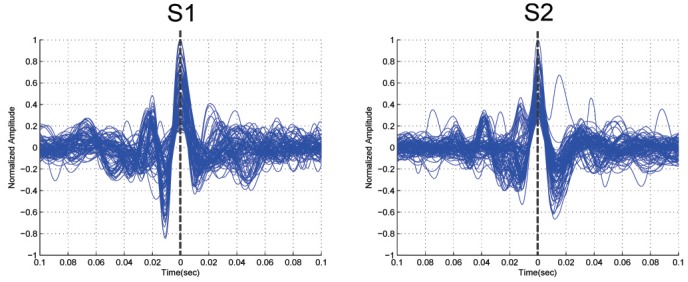
Demarcation of the 1st (S1) and 2nd (S2) heart sounds.The normalized amplitude (y-axis) is plotted against time in seconds (x-axis). Time zero second depicts the annotated peaks for S1 and S2 events.